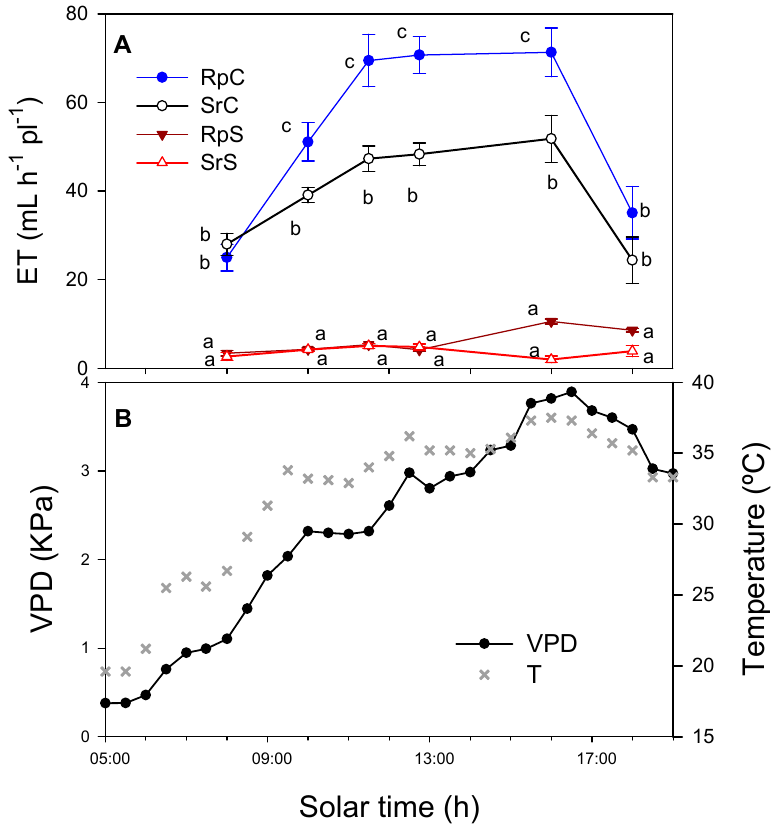
Figure 2. Evolution of hourly evapotranspiration (ET, ( A )) and vapour deficit pressure (VPD and temperature ( B ) throughout a representative day at the end of the water stress period in P. dulcis plants submitted to different treatments. Values are means + s.e., n = 5. Symbols represent the different treatments: RpC (filled circles; plants grafted under full irrigation), SrC (open circles; self-rooted plants under full irrigation), RpS (filled triangles; plants grafted submitted to water stress) and SrS (open triangles; self-rooted plants submitted to water stress). Different lowercase letters indicate significant differences between treatments according to Duncan 0.05 test.